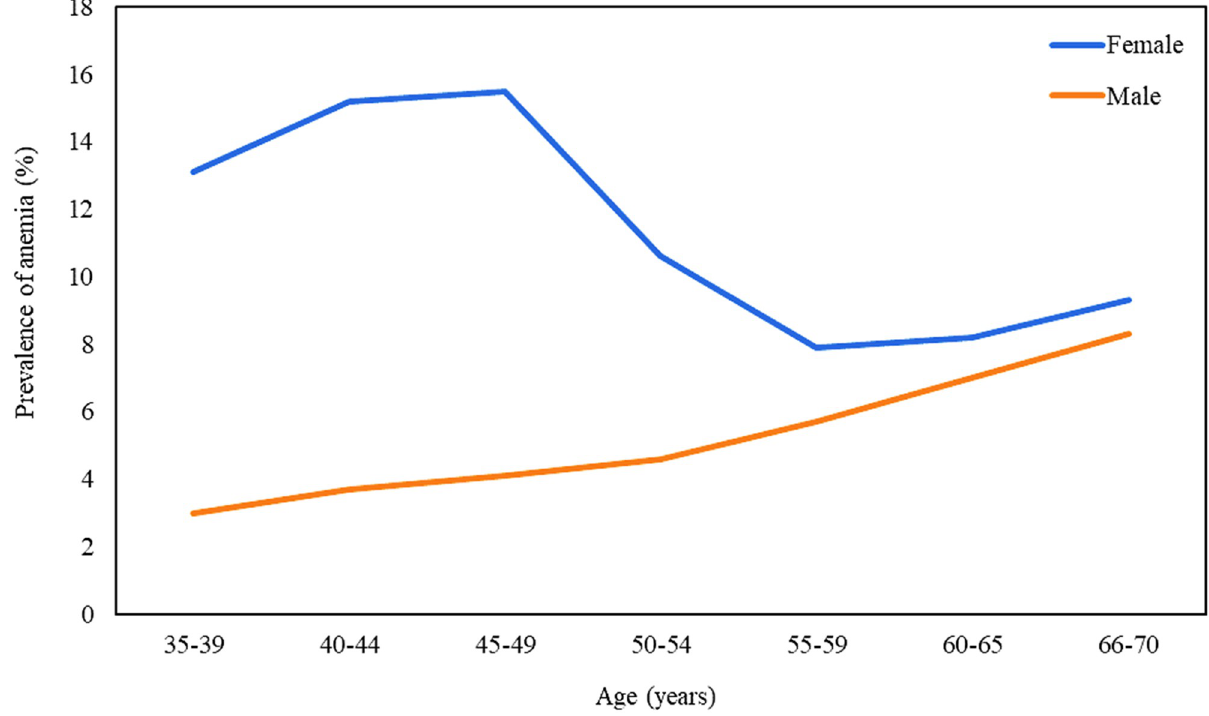
Fig 2. Age-specific prevalence of anemia by